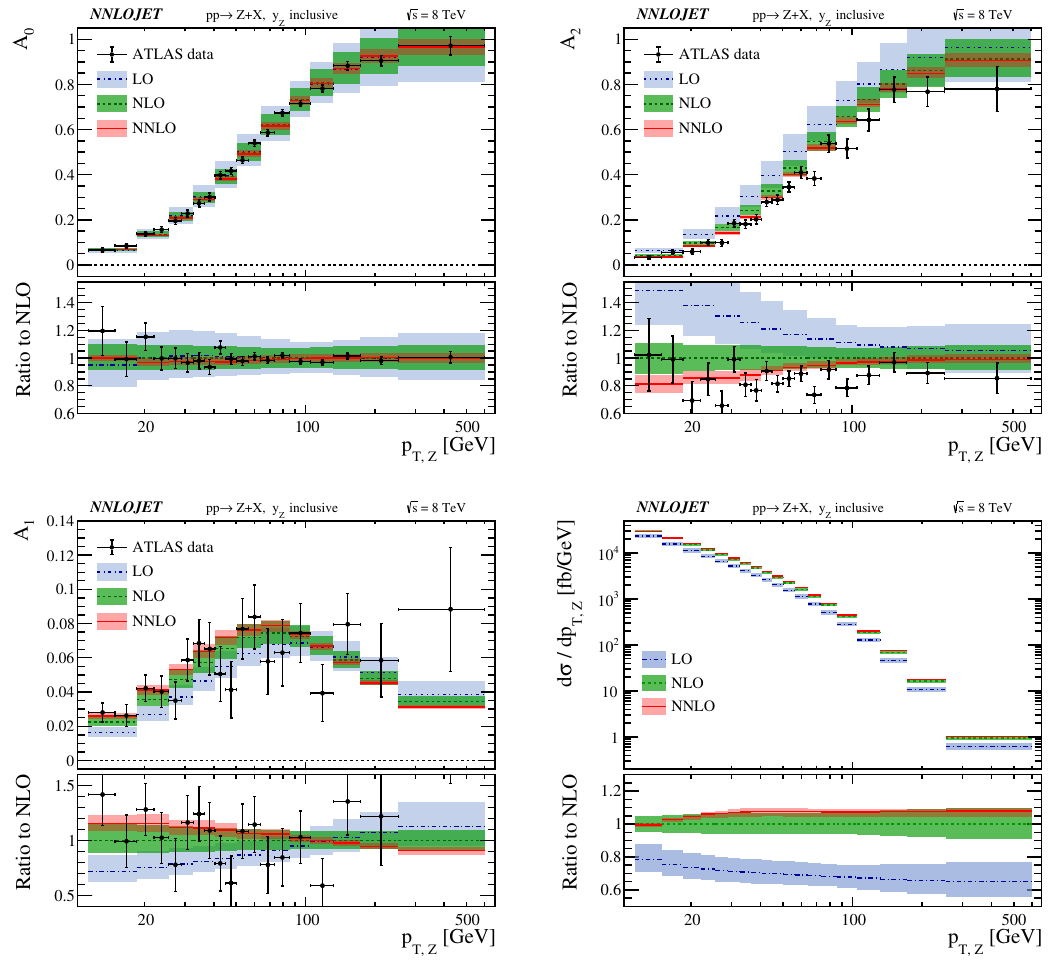
Figure 4 . The p T ; Z distribution for the angular coe(cid:14)cients A 0 (upper left), A 2 (upper right), A 1 (lower left), and the unpolarised cross section (lower right) in pp collisions at ATLAS data (black points) are compared to the LO (blue (cid:12)ll), NLO (green (cid:12)ll), and NNLO (red (cid:12)ll) theoretical predictions. In the lower panel, each distribution is shown normalised with respect to the central NLO